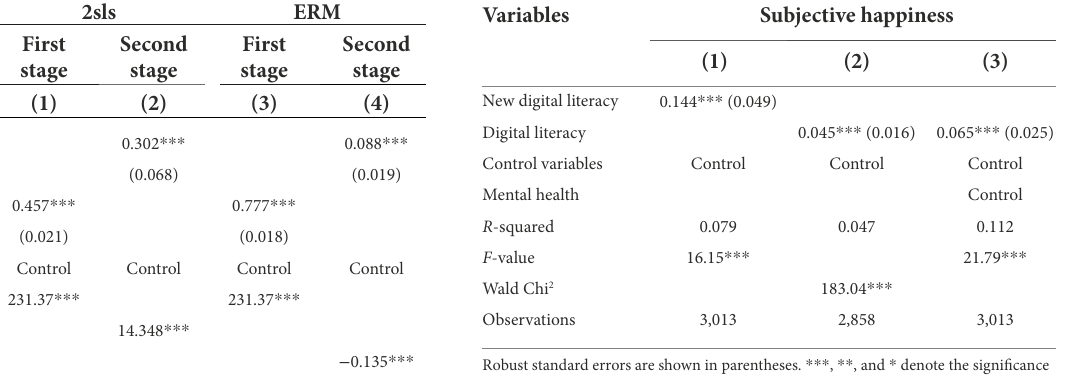
TABLE 3 Estimation results of the instrumental variable method. TABLE 4 Results of robustness